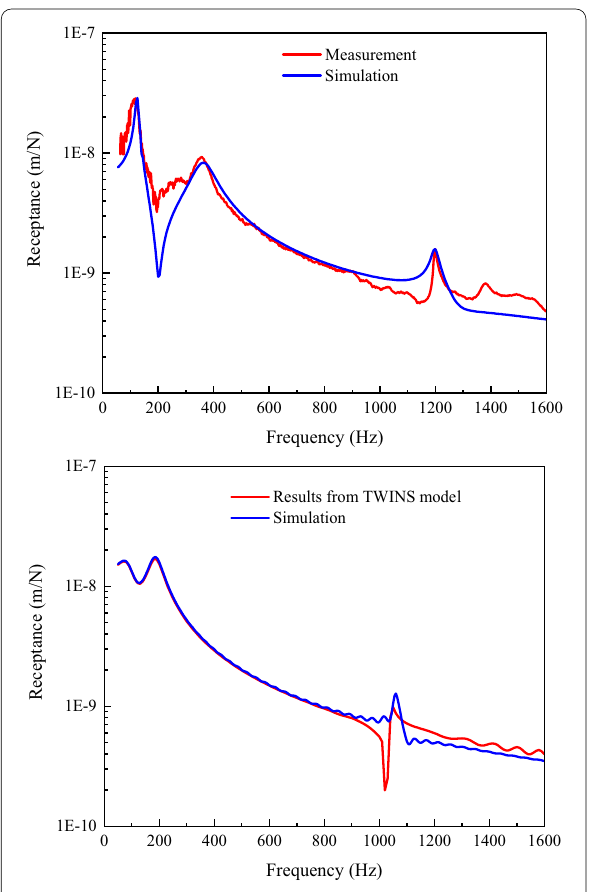
Figure 16 Wheel-rail noise prediction model validation: ( a ) Rubber-booted short sleeper track and ( b ) Ballast track